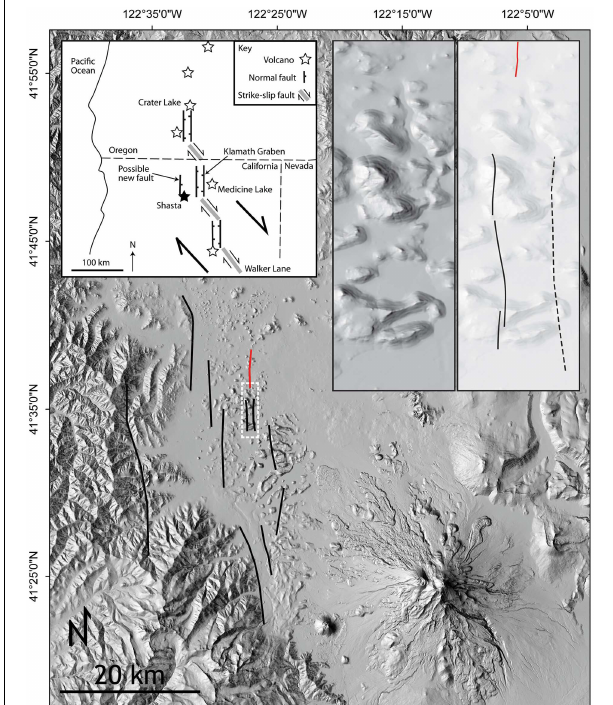
FIGURE 4 | Other possible sites affected by faulting on the Shasta DAD NED-derived shaded relief DTM, with the detected fault in red. Top left inset shows a possible regional kinematic explanation of this new observation, with a westerly extension of the Cascades extensional zone. Top right inset shows detail of the possible faults seen to the south of the LiDAR-detected